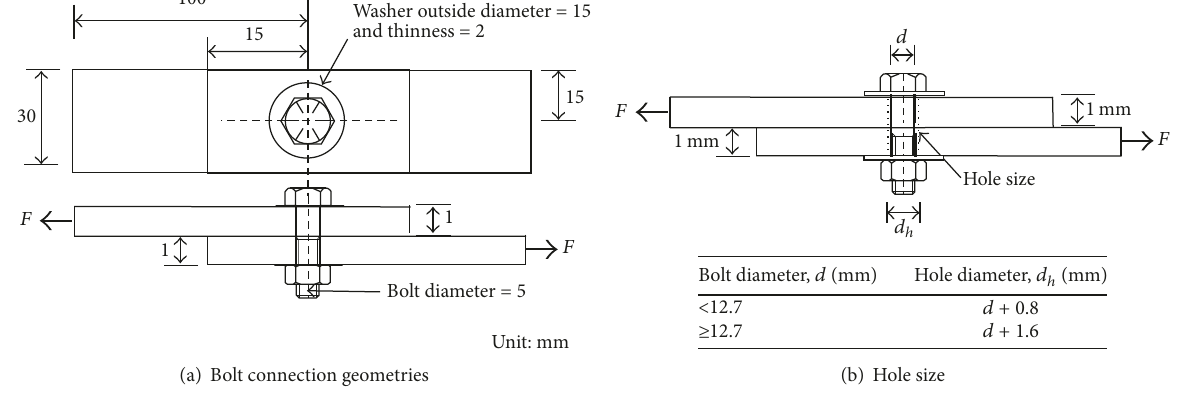
Figure 2: Bolt connection specimens. Table 1: Material properties of cold-formed steel, G550-1T.